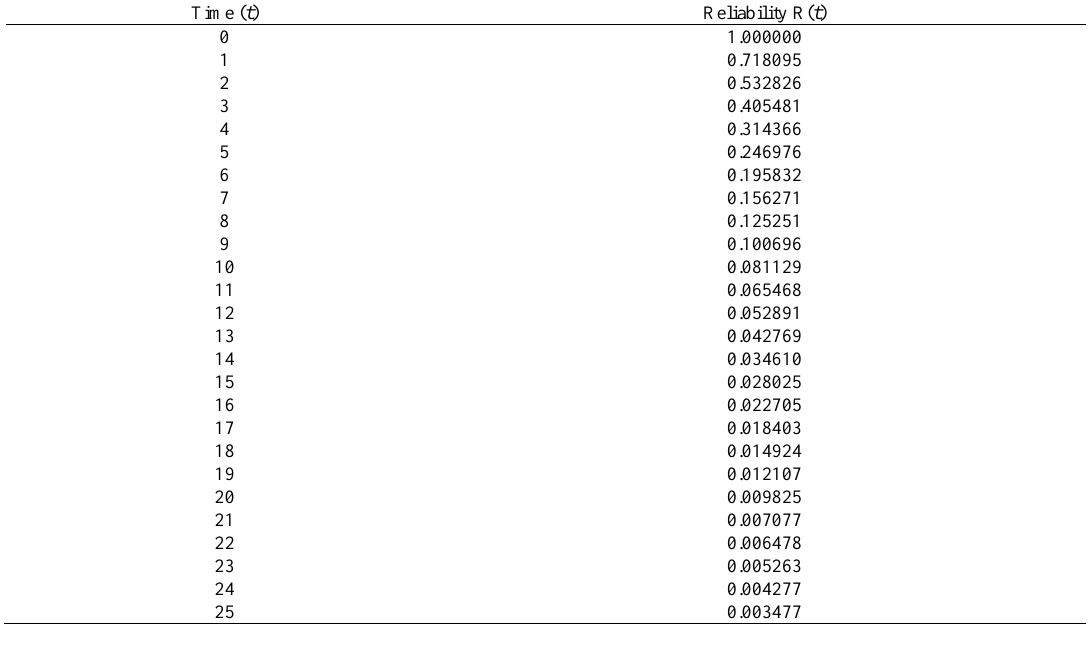
Table 7 . Reliability of the system with copula.